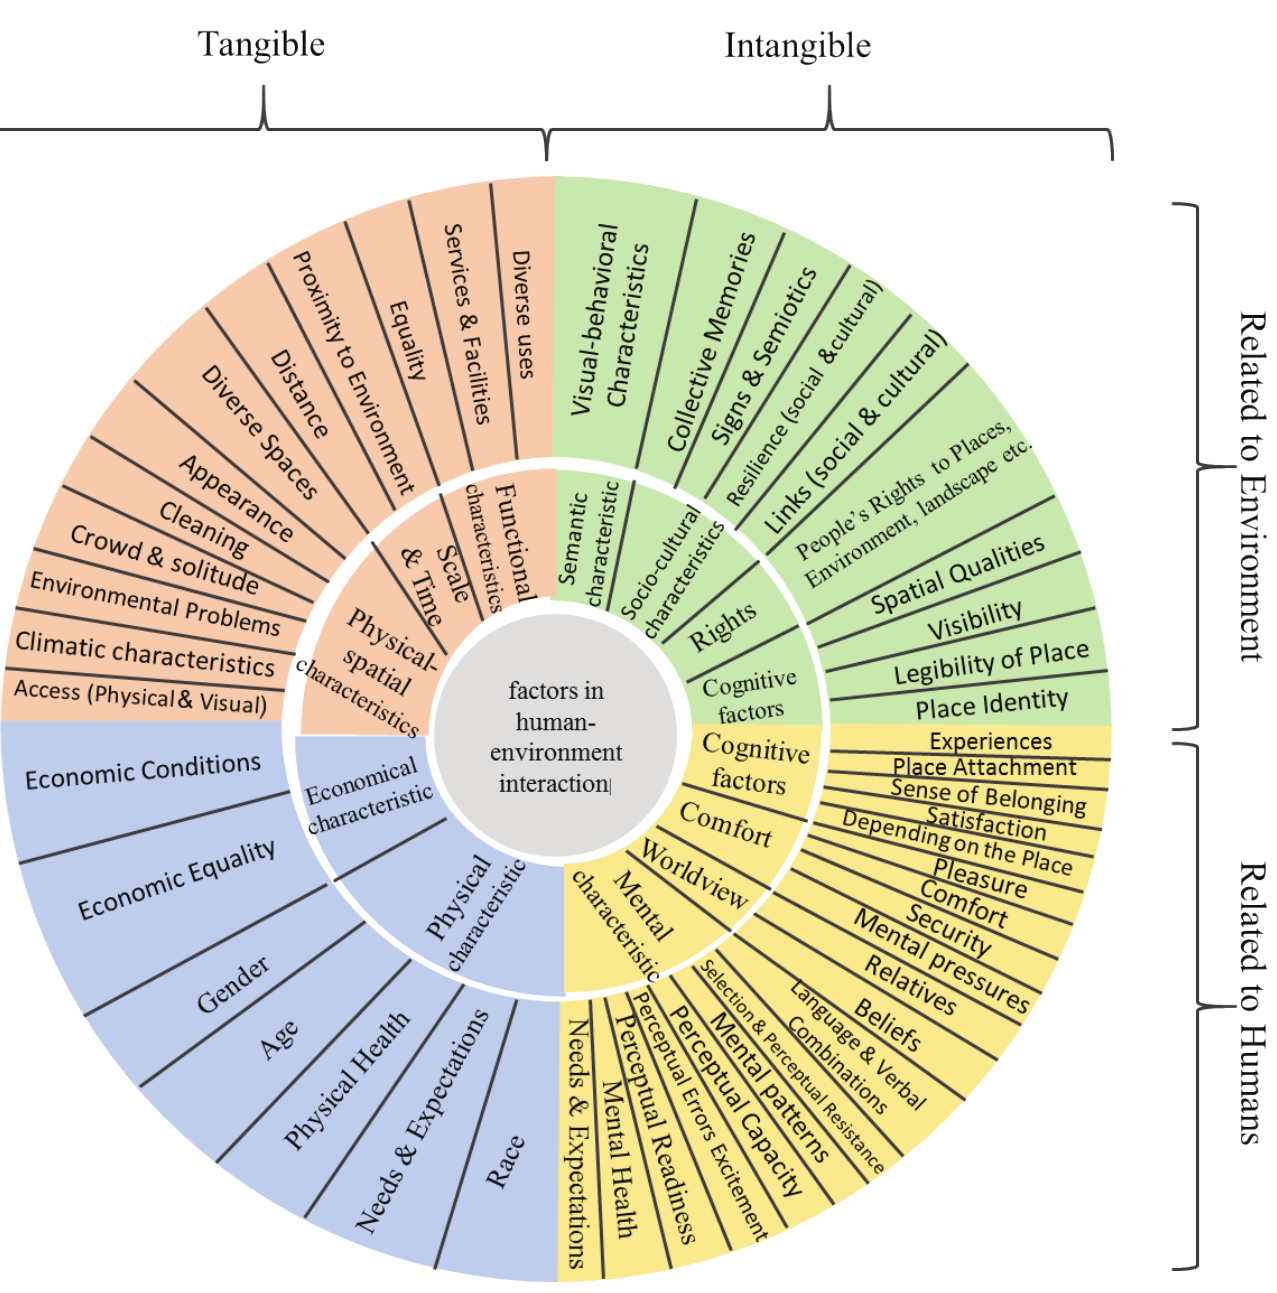
Figure 2. Factors influencing human-environment